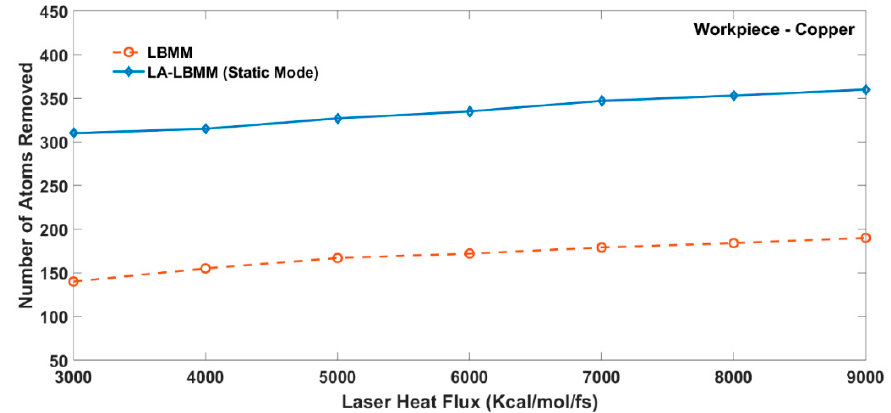
Figure 10. Variation in Number of Atoms Removed with respect to Heat Flux during LBMM and LA-LBMM Process (Static Mode) on Cu Substrate.